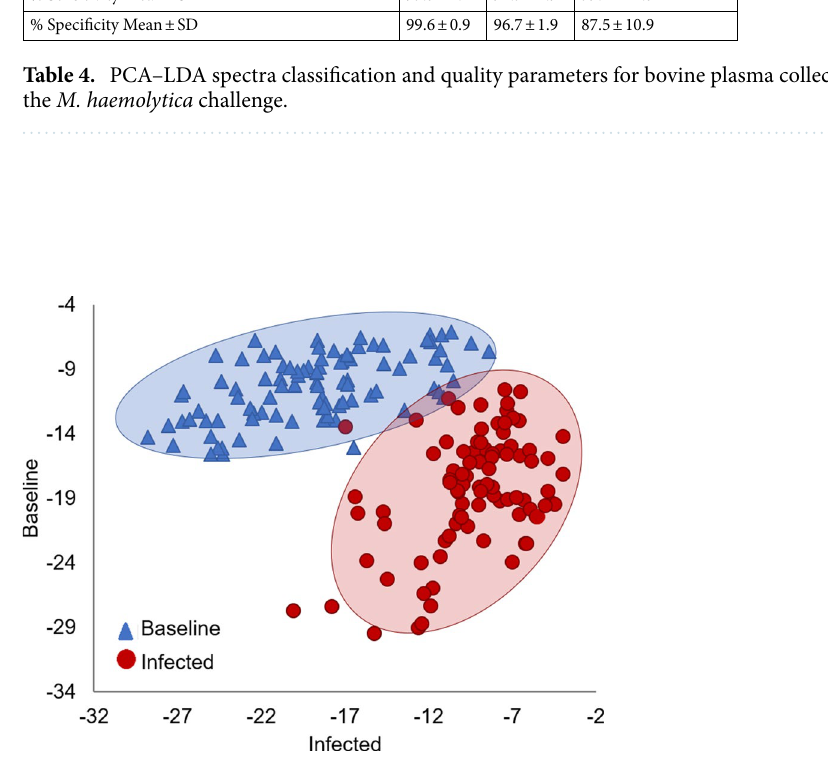
Figure 5. PCA–LDA plot for the calibration database DB1 excluding calf 1. Baseline = 100%, Infected = 97.9% of accurately classified spectra from bovine blood plasma collected before and after the M. haemolytica